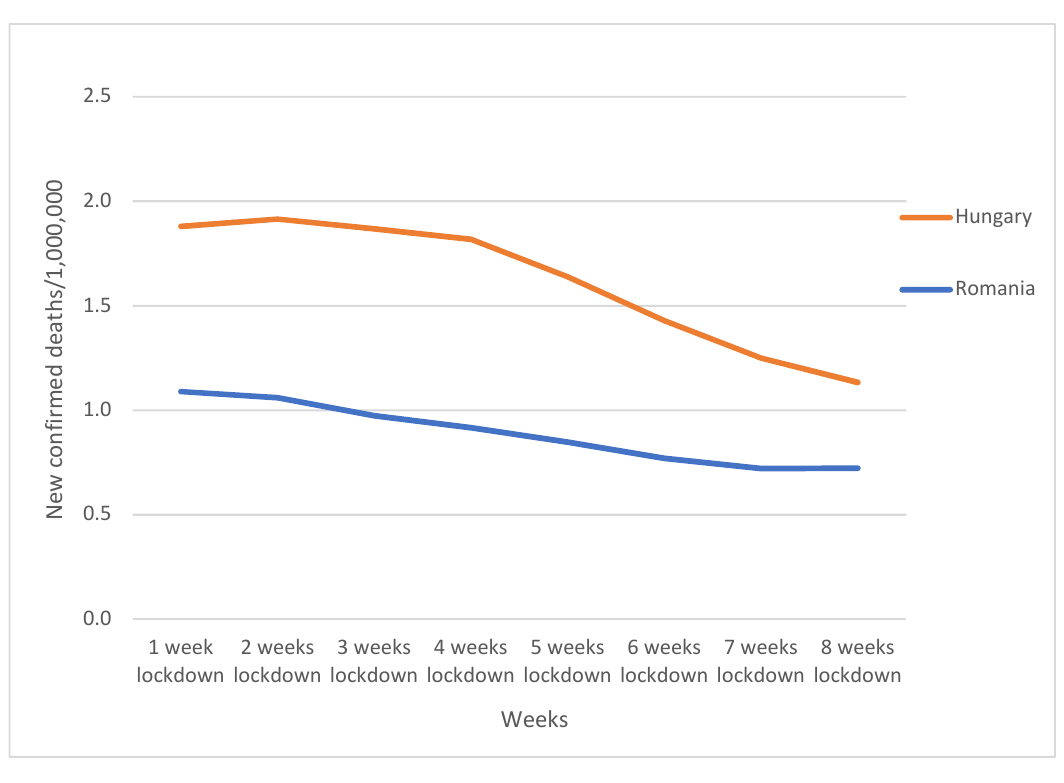
Figure 4. New confirmed COVID-19 deaths/1,000,000.